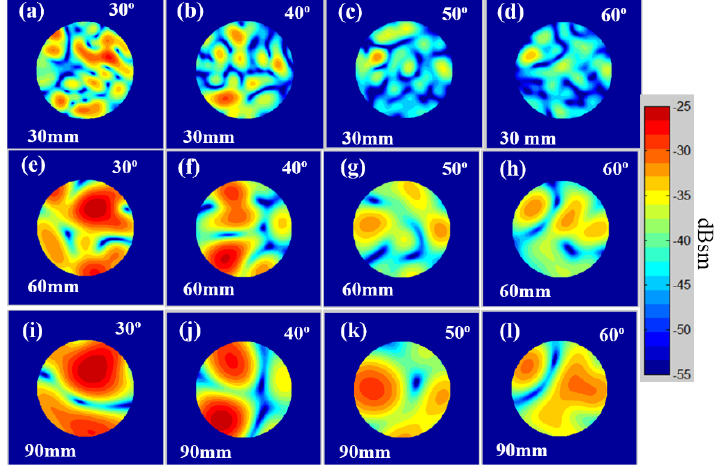
Figure 8. Image example of the exponentially correlated rough surface sample at different resolutions (30 mm, 60 mm and 90 mm) and different θ i (30°, 40°, 50° and 60°), VV.